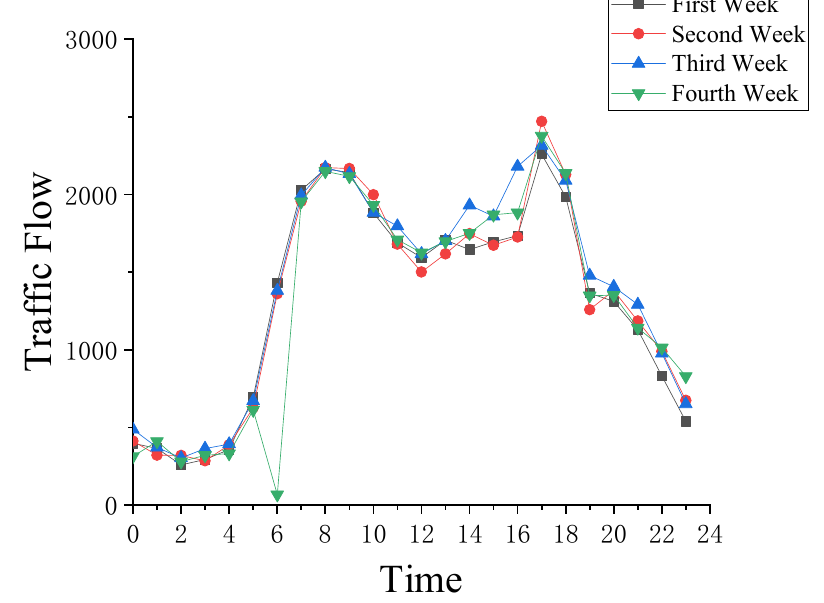
Figure 2. The Jiangdong Bridge traffic flow in August 2020.